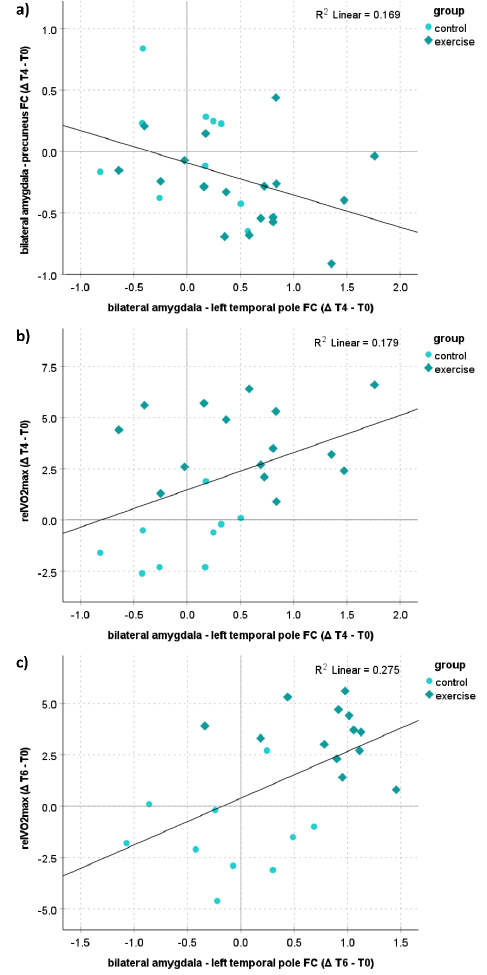
Figure 5. Correlations between physical fitness and FC. ( a ) Shows the correlation between the amygdala-precuneus FC and amygdala-temporal pole FC from T0 to T4; ( b ) shows the correlation between the relVO 2max [mL/min/kg] and amygdala-temporal pole FC from T0 to T4; ( c ) shows the correlation between the relVO 2max [mL/min/kg] and amygdala-temporal pole FC from T0 to T6.